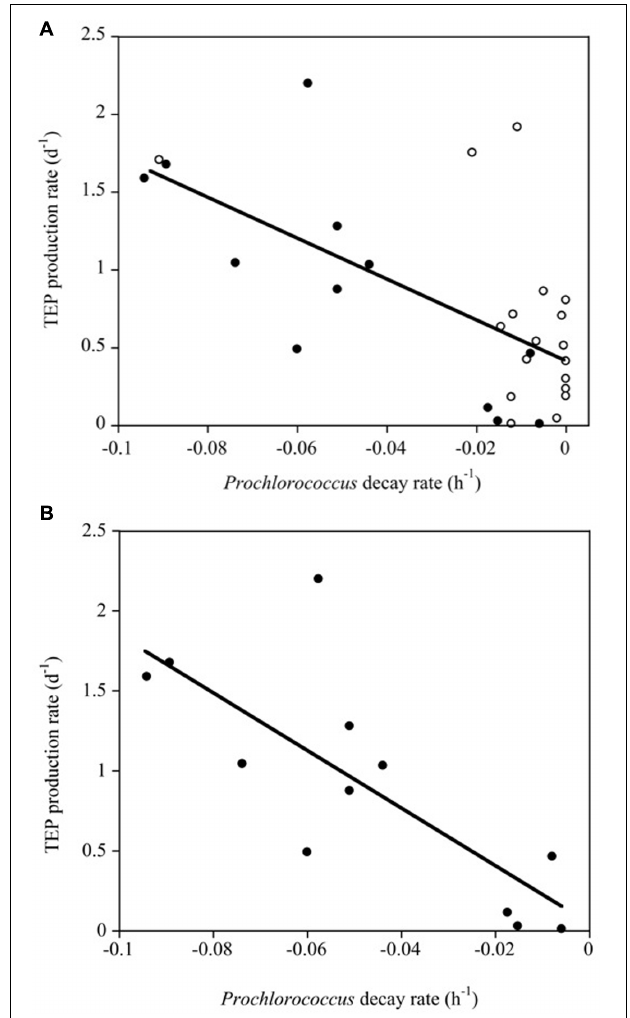
FIGURE 6 | (A) Linear regression between TEP production rates (d − 1 ) and Prochlorococcus decay rates (h − 1 ) in the experiments ( R 2 = 0.41, p < 0.0001). White and black solid dots correspond to data of the Atlantic and Pacific experiments, respectively. (B) Linear relationships between TEP production rates (d − 1 ) and Prochlorococcus decay rates (h − 1 ) for the Pacific experiments alone (black dots, R 2 = 0.60, p <